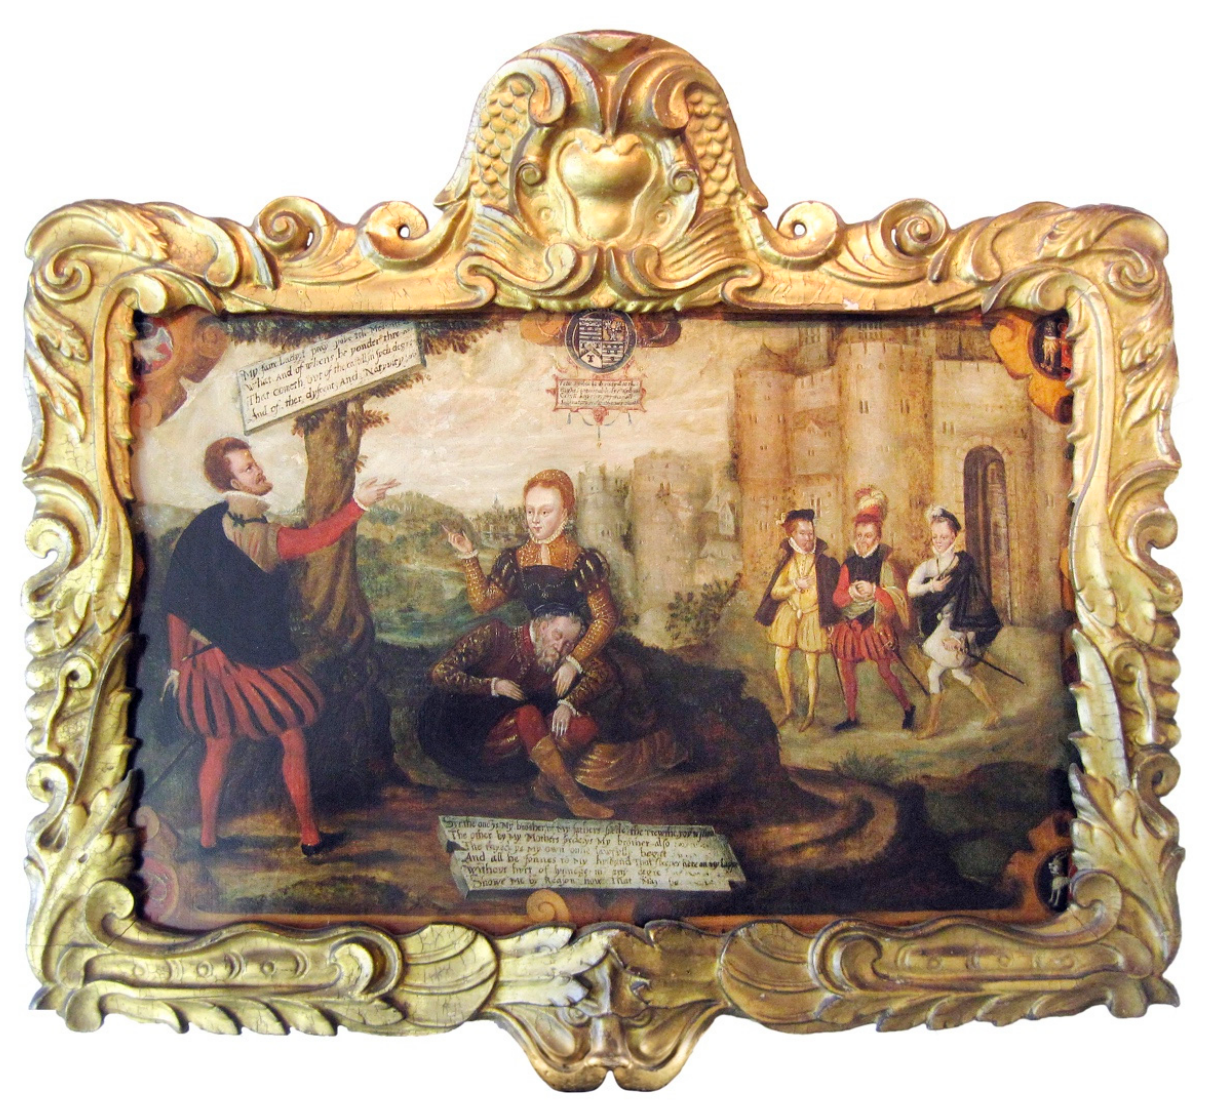
Figure 8. Riddle devoted to Sir William Cecil, c. 1565–70. Hatfield House, Hertfordshire, UK. Cour- Courtesy of the Marquess of Salisbury. Photo credit: Lyndan tesy of the Marquess of Salisbury. Photo credit: Lyndan Warner.